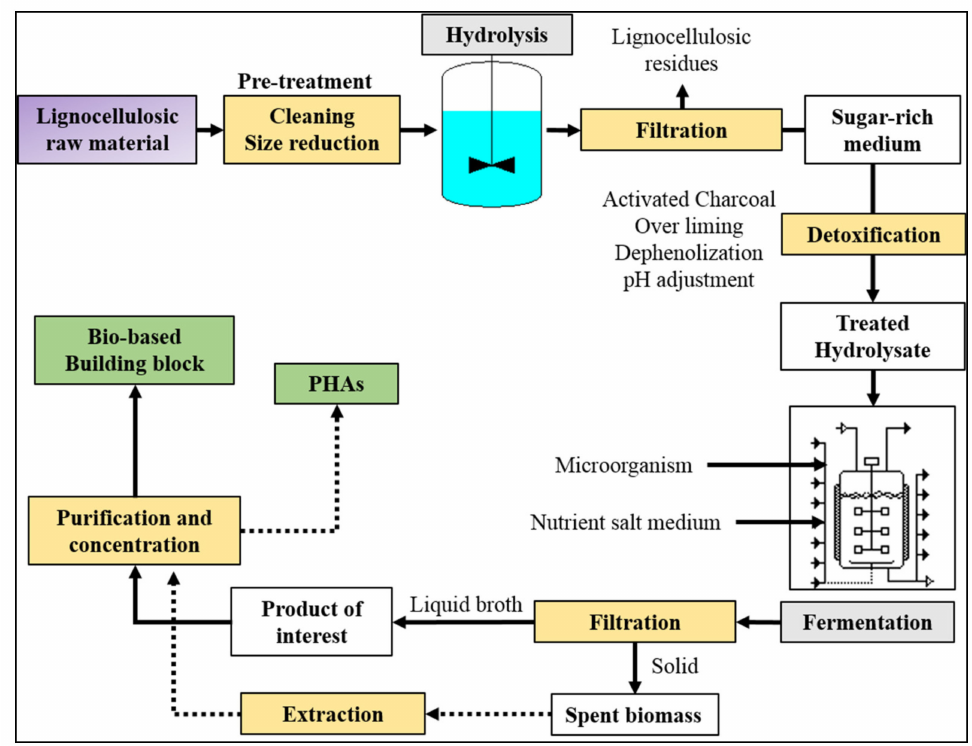
Figure 3. Schematic diagram for the obtainment of bio-based building blocks and poly(hydroxyalkanoates) (PHAs) using lignocellulosic raw